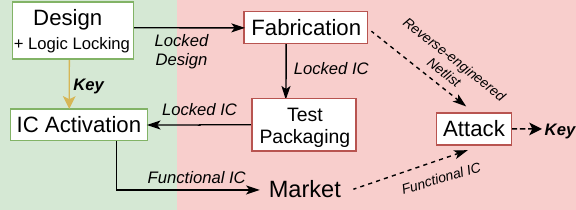
Figure 2. IC supply chain and threat model on logic locking.